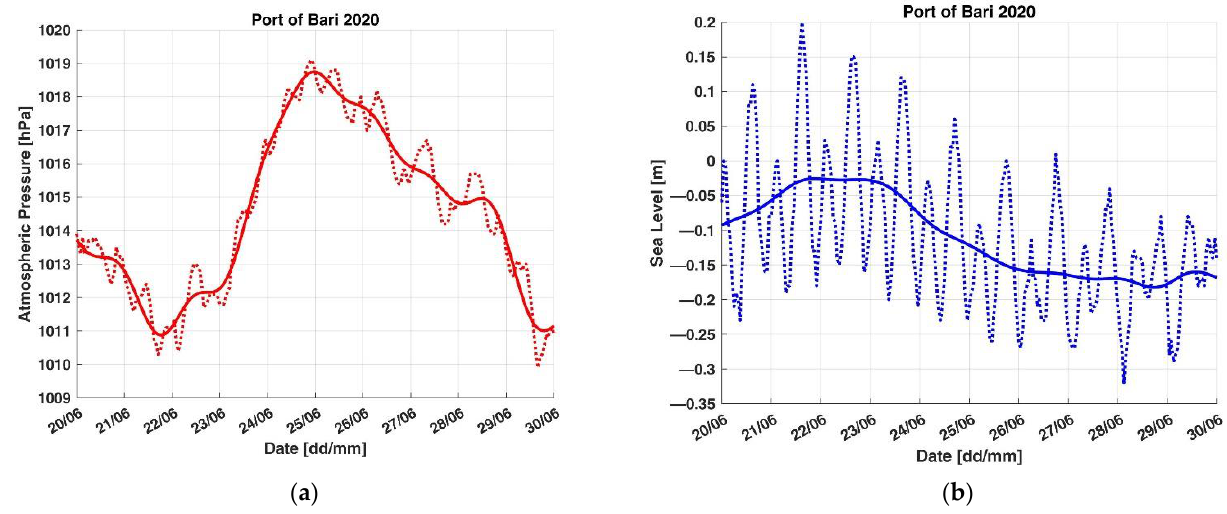
Figure A20. Low-frequency components of meteo-mareographic parameters acquired by ISPRA’s monitoring station in the port of Bari from 20 to 30 June 2020: ( a ) atmospheric pressure; ( b ) sea level.